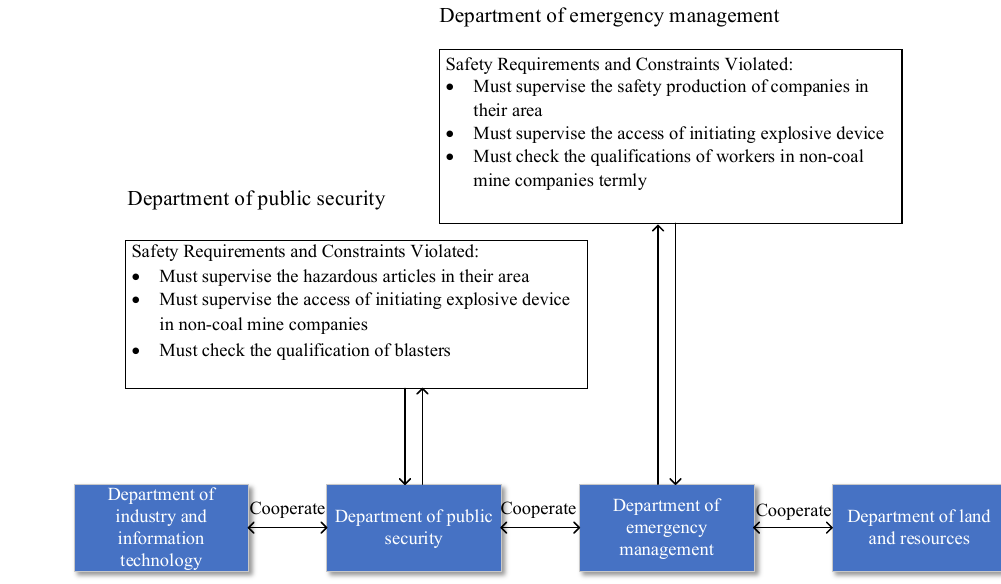
Figure 9. Supervision level